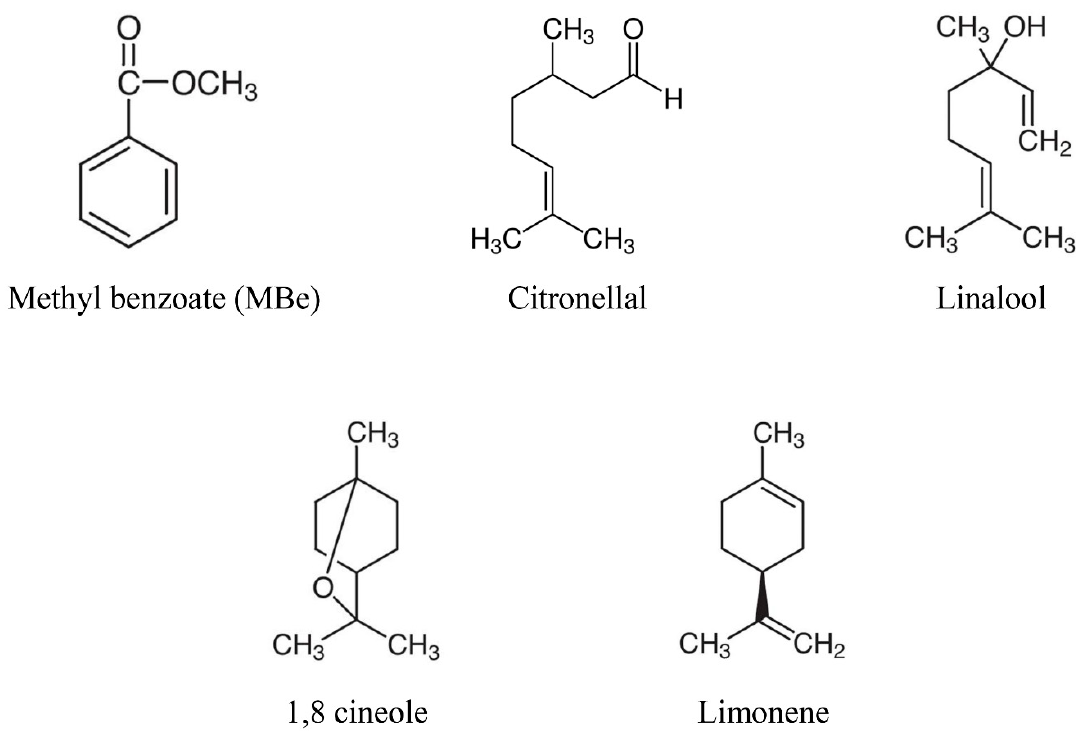
Figure 1. The chemical structures of methyl benzoate (MBe) and the other tested